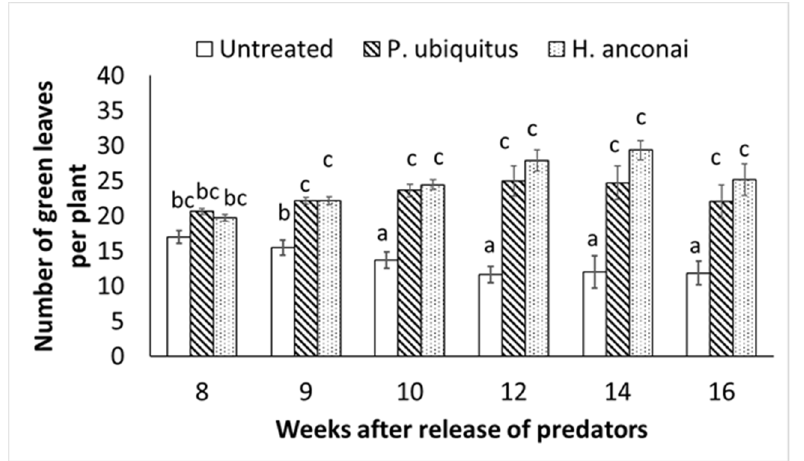
Figure 5. Remaining healthy (green) leaves per treatment. Different letters indicate a significant difference in the number of green leaves between the inoculated tomato plants and the control plants (linear mixed-effects models, p < 0.05).